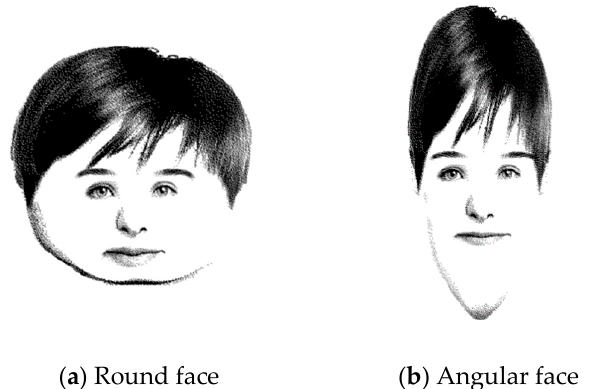
Figure 1. Round and angular faces presented to participants.